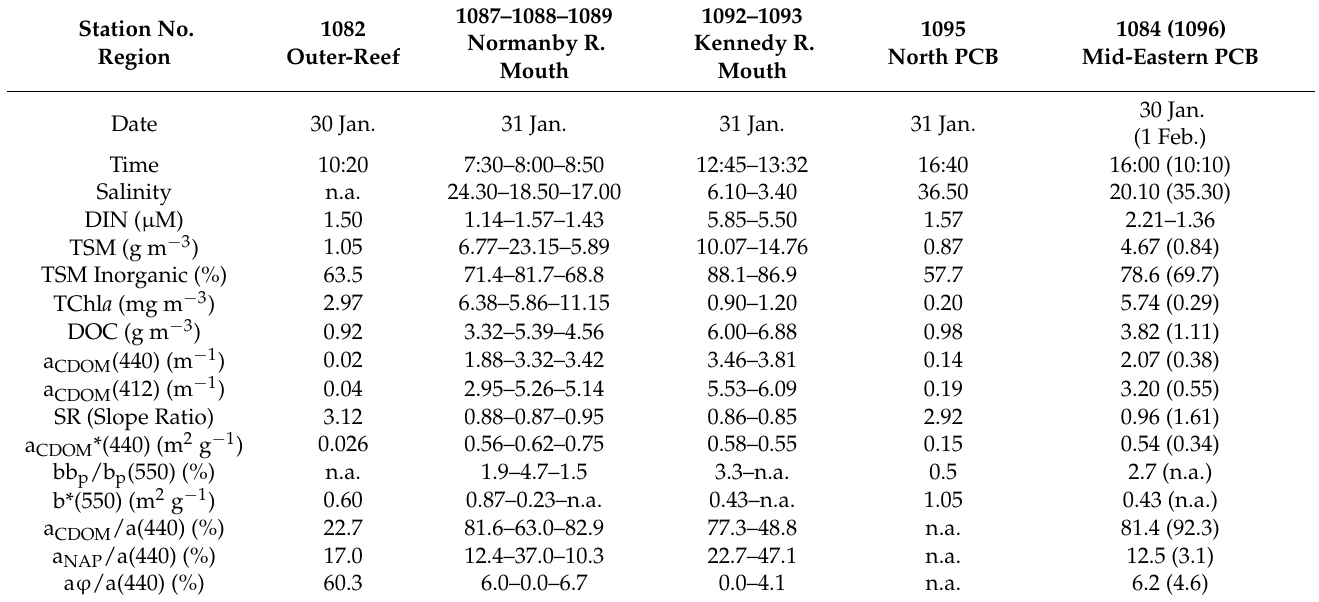
Table 1. Surface values for environmental and biogeochemical quantities at key stations in Princess Charlotte Bay. ‘n.a.’ denotes measurements were not